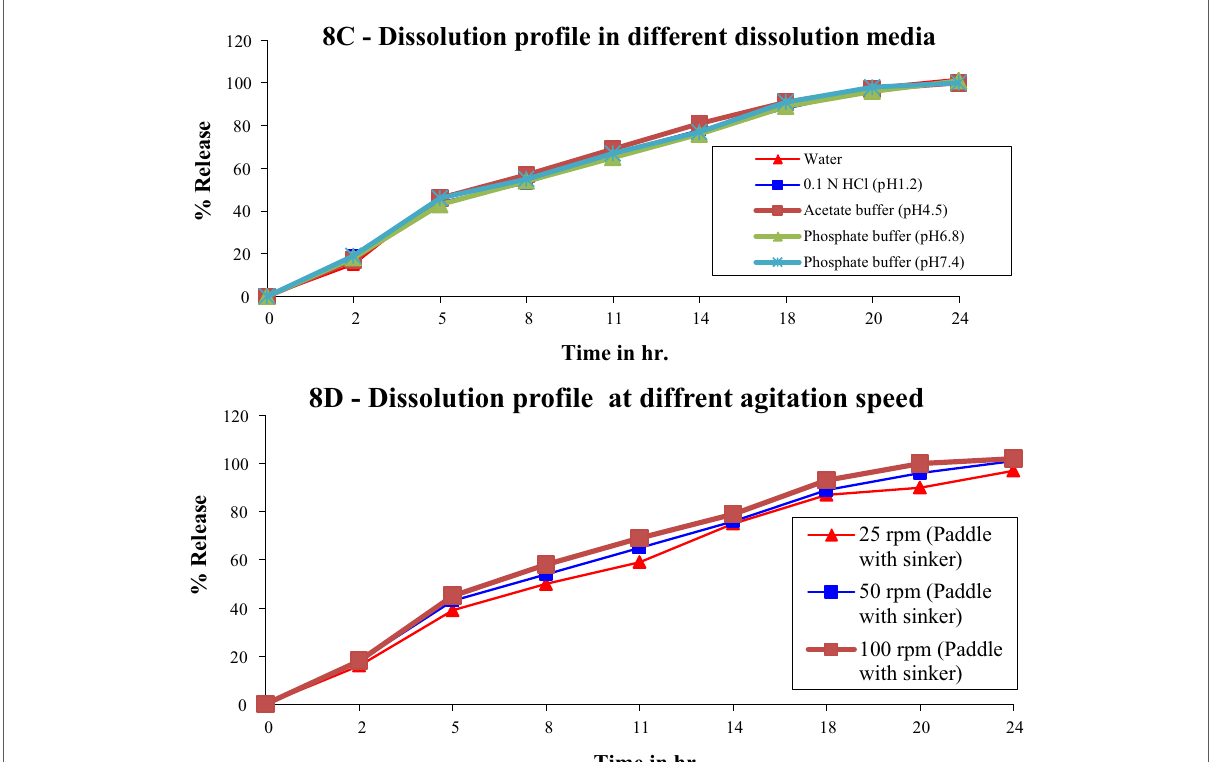
Fig. 8 a Impact of different % weight gain by ER coating on drug release (TSP-18), b impact of drill orifice diameter on drug release (TSP-18), c Impact of dissolution media pH on drug release (TSP-18), d impact of agitation speed on drug release